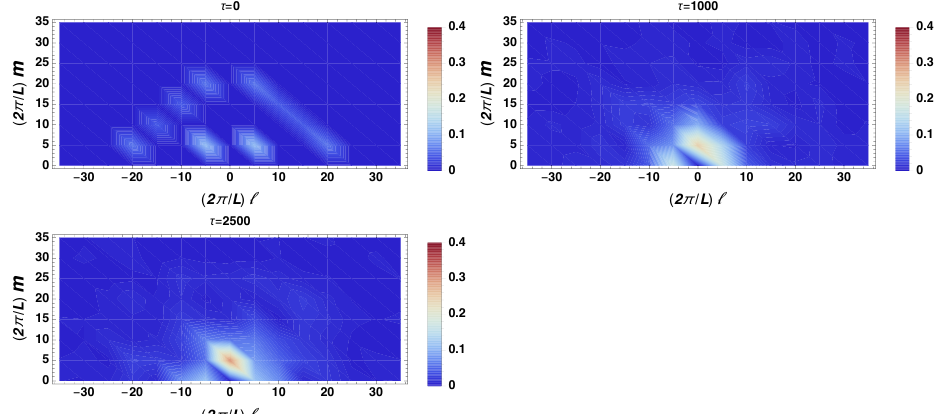
Figure 3. Case A1—inviscid. Contour plots of | ξ (cid:96) , m | (in arbitrary units) as a function of the mode numbers scaled by 2 π / L . The graphs are taken at different times as indicated over the